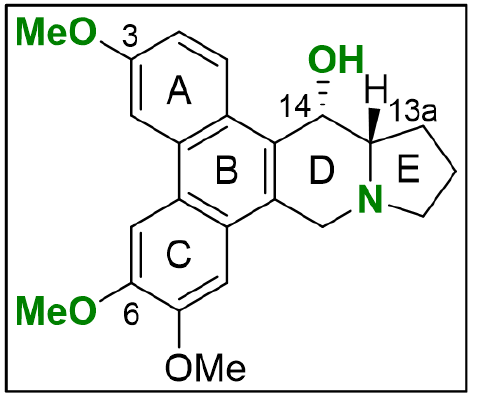
Figure 3. Initial SAR for PAs in TNBC. The scaffold of compounds ( 1 )–( 6 ) are depicted with emphasis on the chemical groups that show major influence on blocking NF κ B signaling (green). The illustration was drawn using ChemDraw (PerkinElmer Informatics, Hamburg, Germany; Version: 18.1.0.458). dependent manner. While the compounds ( 1 ) and ( 1s ) exhibit superior NF κ B